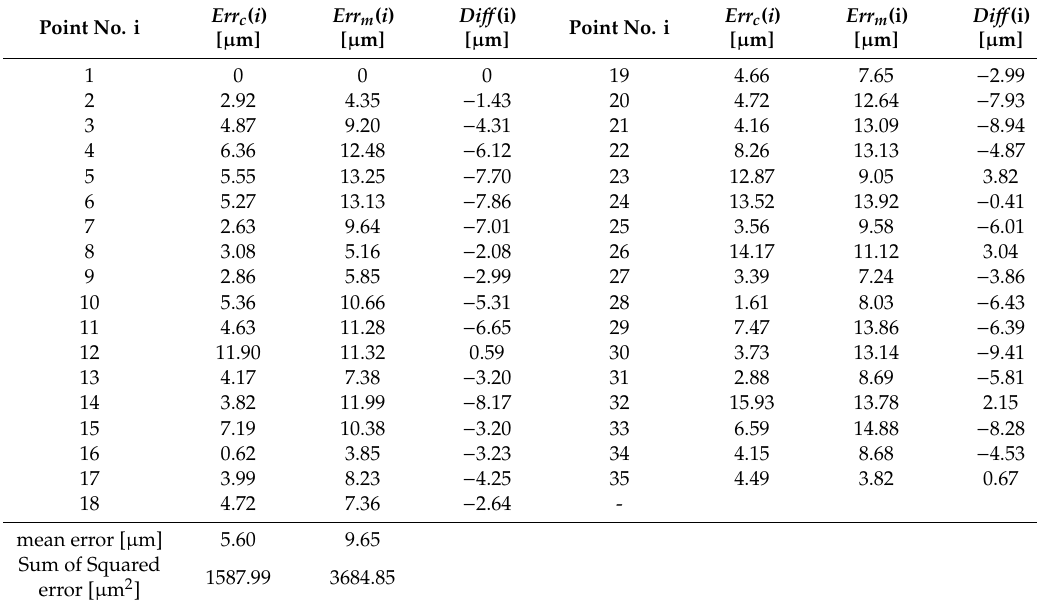
Table 2. The values of the error of each individual point.